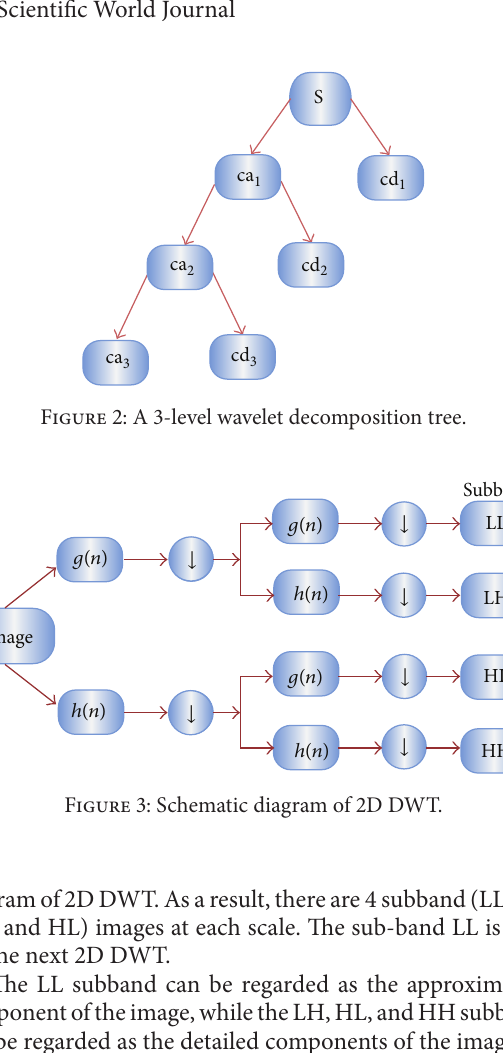
diagram of 2D DWT. As a result, there are 4 subband (LL, LH, HH, and HL) images at each scale. The sub-band LL is used for the next 2D